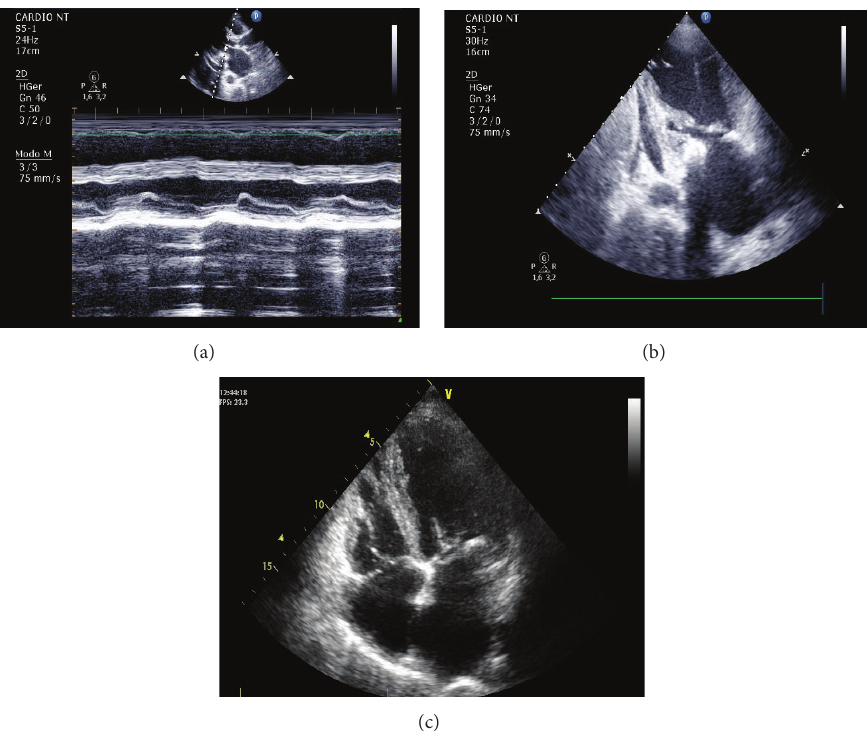
Figure 1: Echocardiographic findings: (a) parasternal incidence long axis, mitral valve M-mode, fibrotic leaflets, with limited leaflet excursion mobility, and annular calcification; (b) apical 2-chamber view, left LV, LA, mitral valve with fibrotic leaflet, and subvalvular apparatus and annular calcification; (c) apical 4-chamber view, LV, LA, RV, RA, mitral valve with fibrotic leaflet, and subvalvular apparatus and annular calcification.